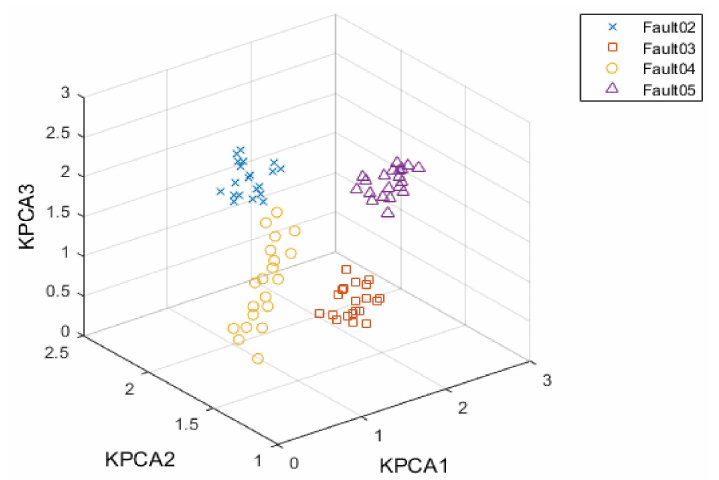
Figure 27. VMD‑MMFD‑KPCA feature